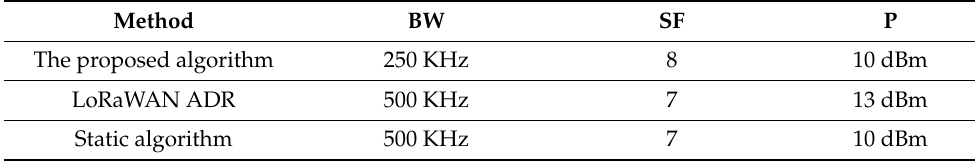
Figure 13. PRR variation for the different algorithms on a single link. Table 6. Final parameter configuration for three methods.